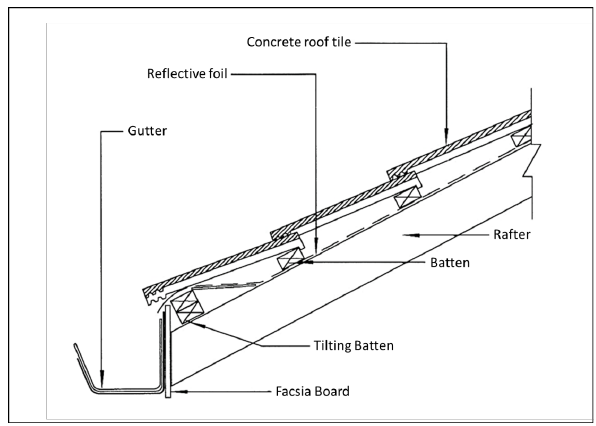
Figure 2: Tiled roof with reflective insulation